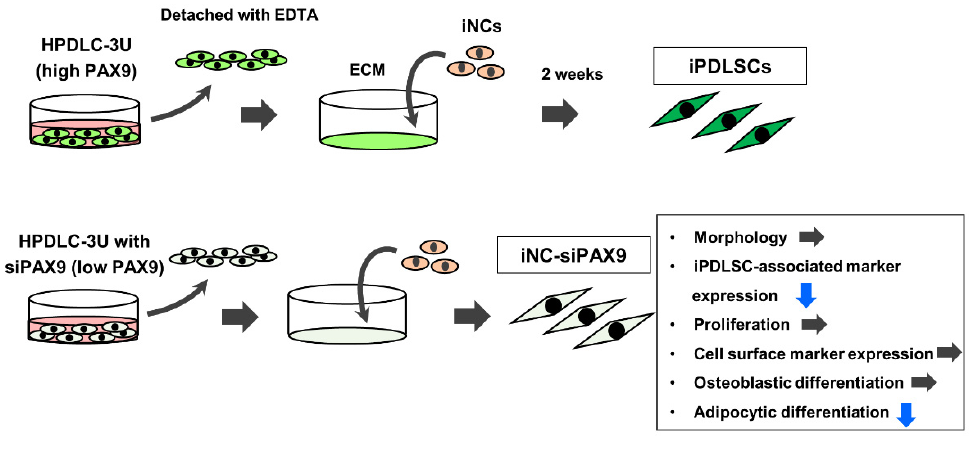
Figure 7. A schematic of the effects of PAX9 downregulation in HPDLC-3U HPDLC-3U cells highly express PAX9 , while iNCs cultured on ECM derived from HPDLC-3U differentiate into iPDLSCs. siPAX9-transfected HPDLC-3U downregulates PAX9 gene expression. iNCs cultured on ECM derived from siPAX9-transfected HPDLC-3U decreased the expression of iPDLSC-associated markers and the ability to differentiate into adipocytes. ECM, extracellular matrix; iNC, induced pluripotent stem cell-derived neural crest-like cells.